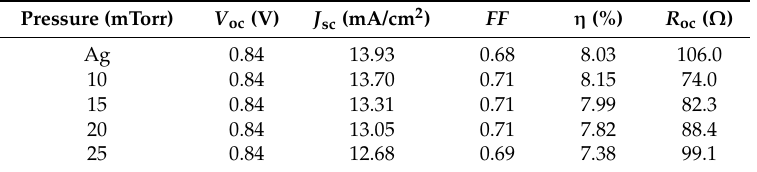
Figure 4. I - V curves of p-i-n solar cells with AlTi back contacts prepared at different pressures. Table 1. Performance of p-i-n solar cells prepared at different pressures. FF : fill factor.